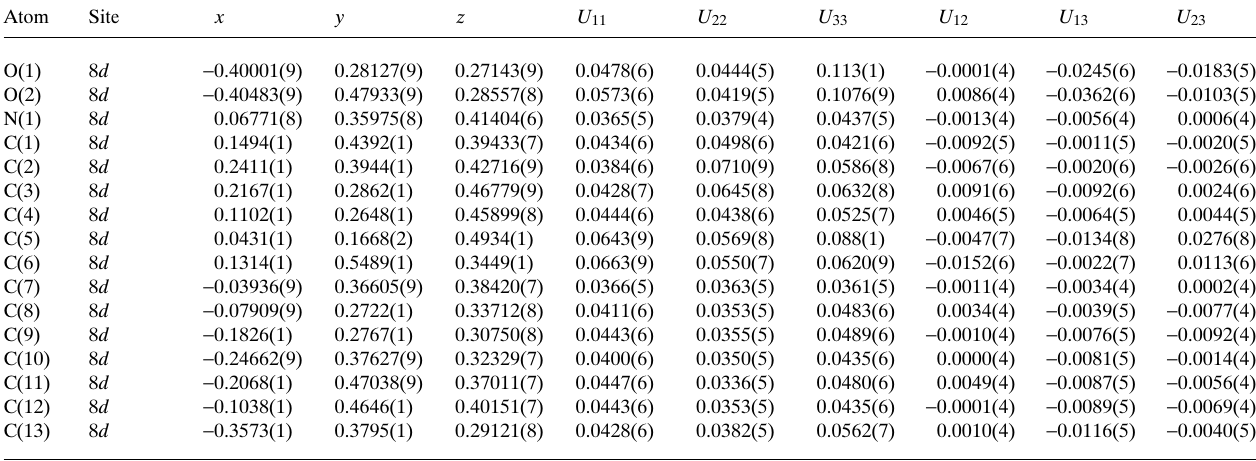
Table 3. Atomic coordinates and displacement parameters (in Å 2 ) .